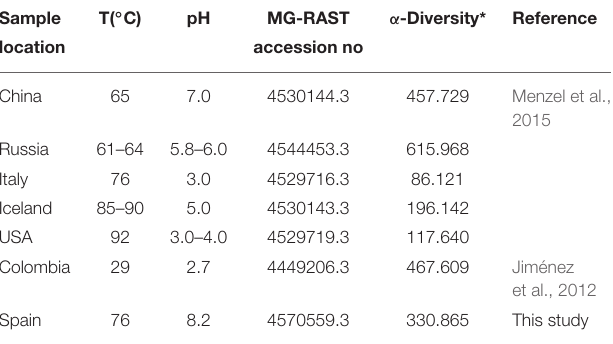
TABLE 1 | Alpha diversity estimates for various hot springs around the